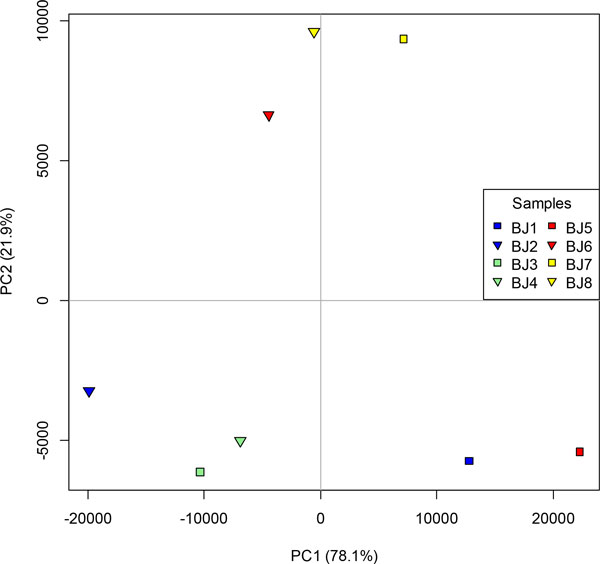
Principal co-ordinates analysis of the eight transcriptome samples mapped to the CLC assembly. Samples are male 3-5h (blue), female 3-5h (green), male 2-3h (red) and female 2-3h (yellow).